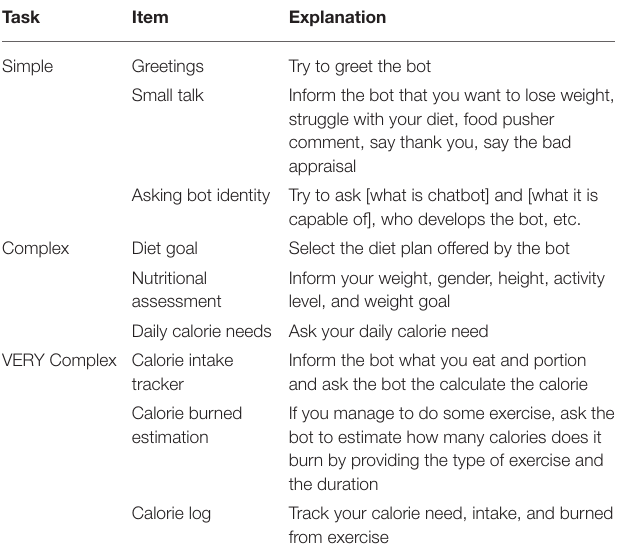
TABLE 1 | SlimMe chatbot simulation